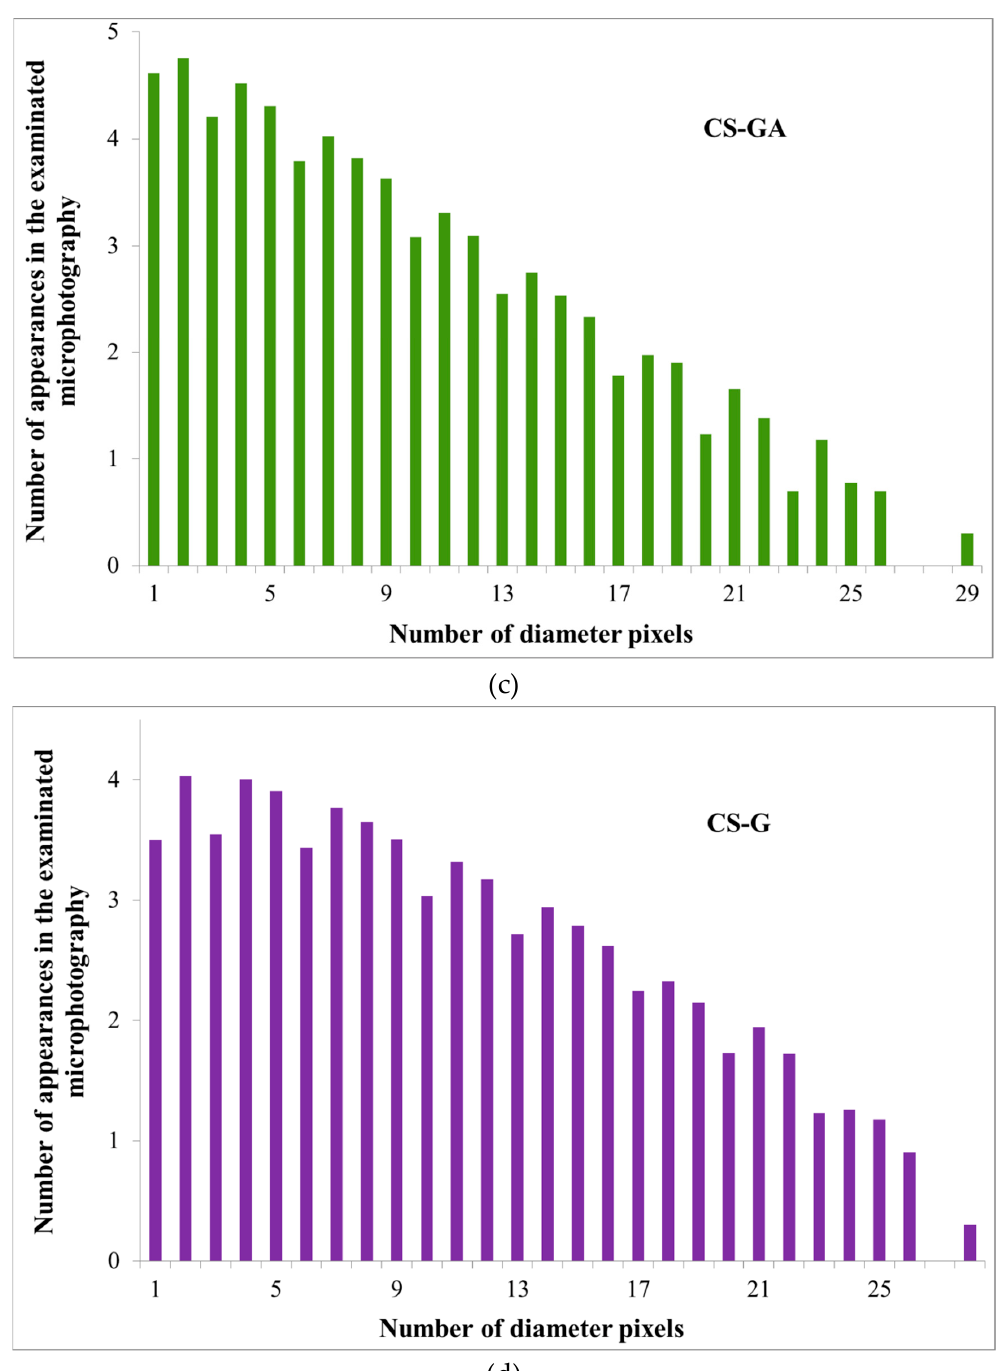
Figure 7. The analysis results of the void diameter distributions for Alg membranes filled with various chitosan particles ( a ) neat (CS), ( b ) phosphorylated (CS ‐ P), ( c ) glutaraldehyde crosslinked (CS ‐ GA), and ( d ) glycidol ‐ modified (CS ‐ G).